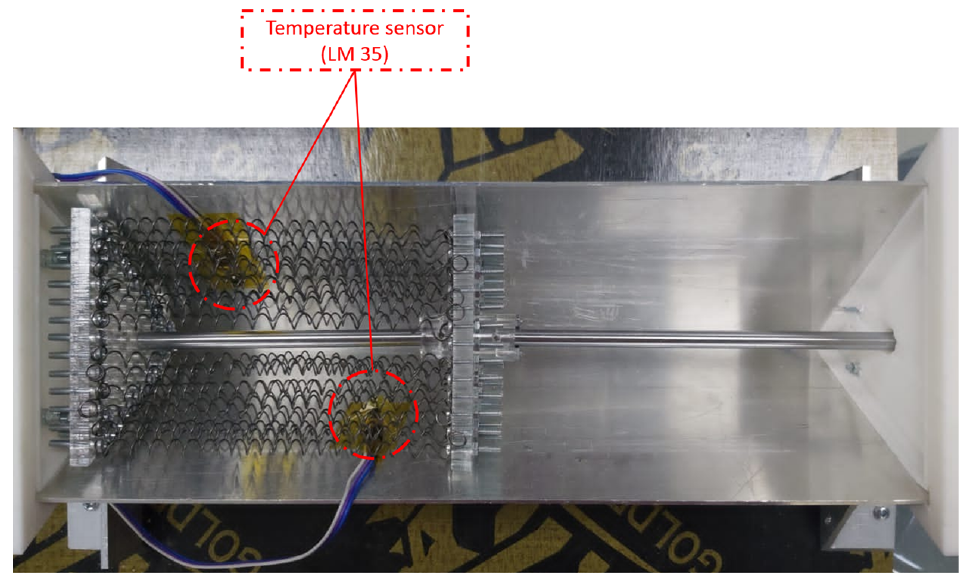
Figure 21. Temperature sensors mounted to the inner surface of the actuator.